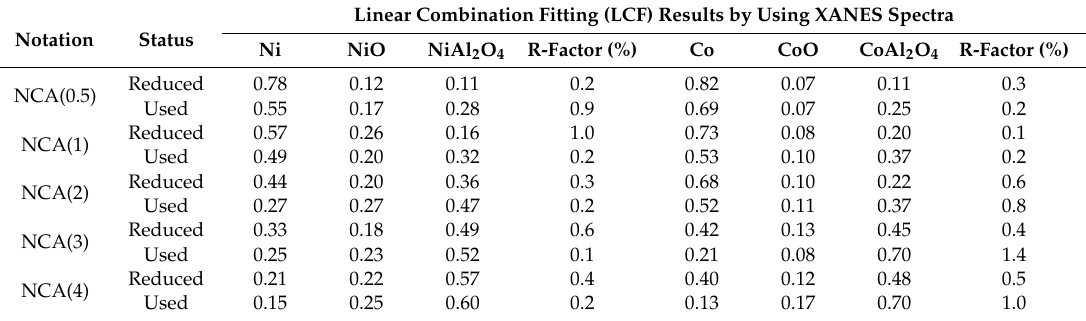
Table 3. Crystalline compositions of the Ni and Co species on the reduced and used NCA catalysts 1 .